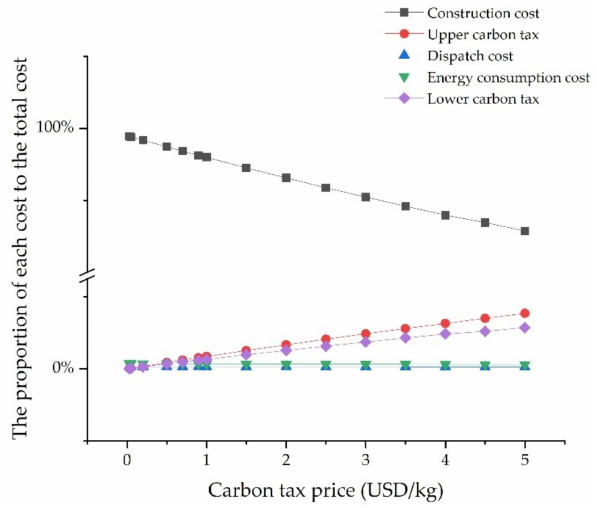
Figure 12. The proportion of each cost to the total cost under different carbon tax